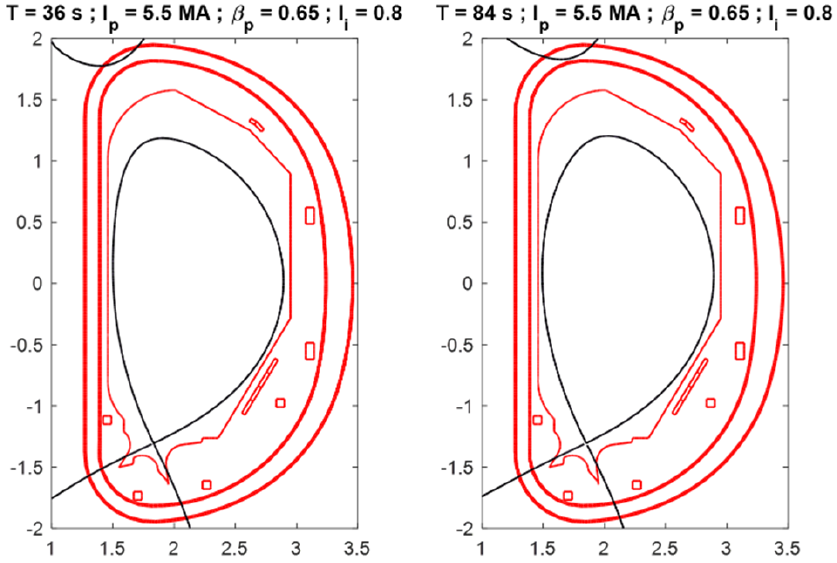
Figure 5. Plasma shapes of SOF and EOF configurations of the SN scenario.